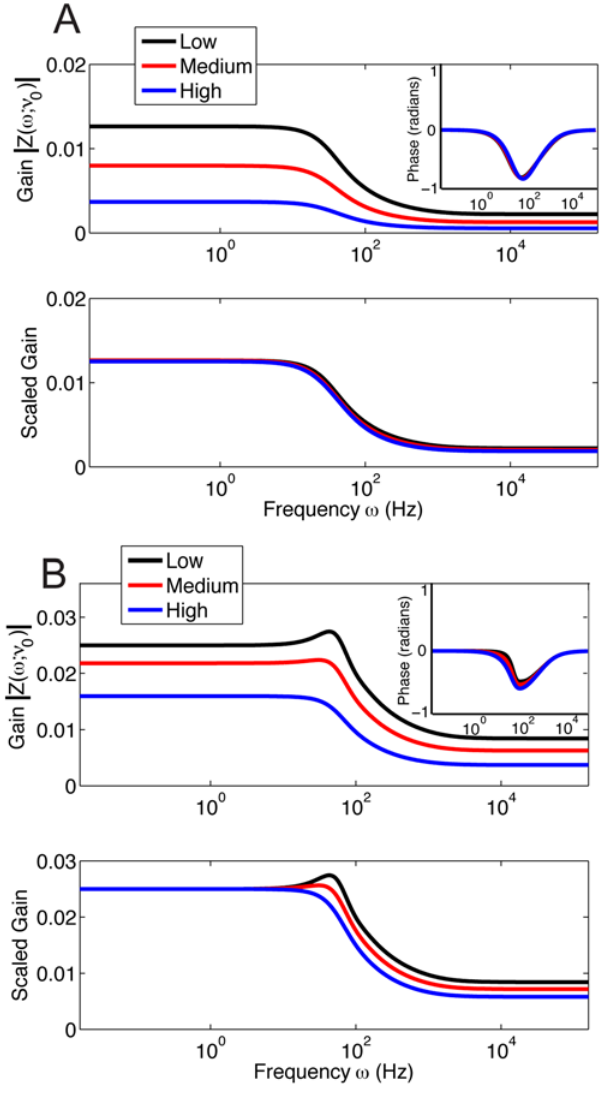
Figure 8. The frequency response in the fluctuation and drift dominated regimes. (A) Fluctuation driven regime. Top Panel: the frequency response is flat up to very large frequencies for all 3 different levels of balanced background activity. In all 3 cases, there was a constant excitatory (cid:1) nn d ~ 2300 s { 1 super-imposed on top of various balanced background inputs: low , medium , and high . Bottom Panel: the frequency responses for the 3 different levels of balanced background in Figs. 2 and 3) for activity are scaled the same multiplicative factor ( c eq j a large range of frequencies. (B) Drift dominated regime. Top Panel: the frequency response for 3 levels of balanced background activity with a constant excitatory (cid:1) nn d ~ 3500 s { 1 super-imposed on top of various balanced background inputs: low, medium and high. Bottom Panel: the frequency responses do not scale in a multiplicative manner. approximation breaks down, meaning that for drift dominated responses any fluctuation induced gain control in the equilibrium regime will not transfer to the nonequilibrium response.